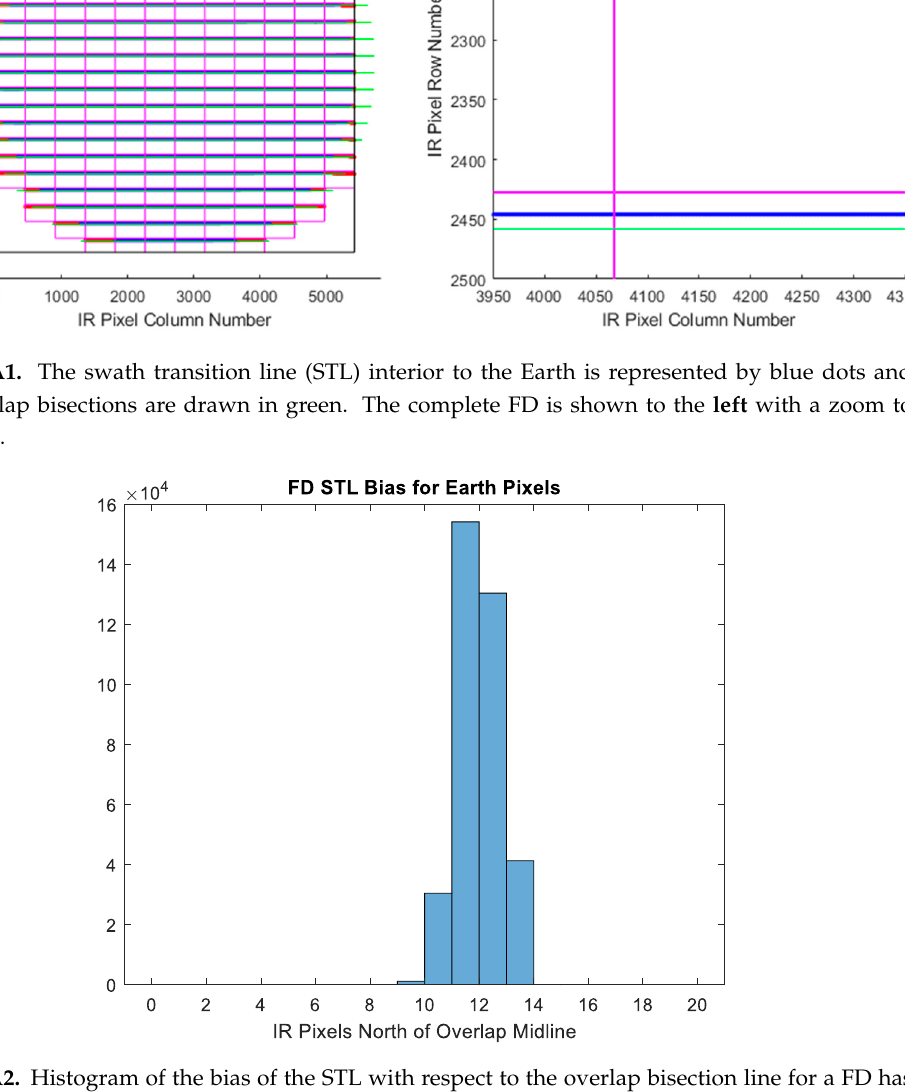
Figure A2. Histogram of the bias of the STL with respect to the overlap bisection line for a FD has a median value of 11 and a mean of 11.5 2 km IR pixels.